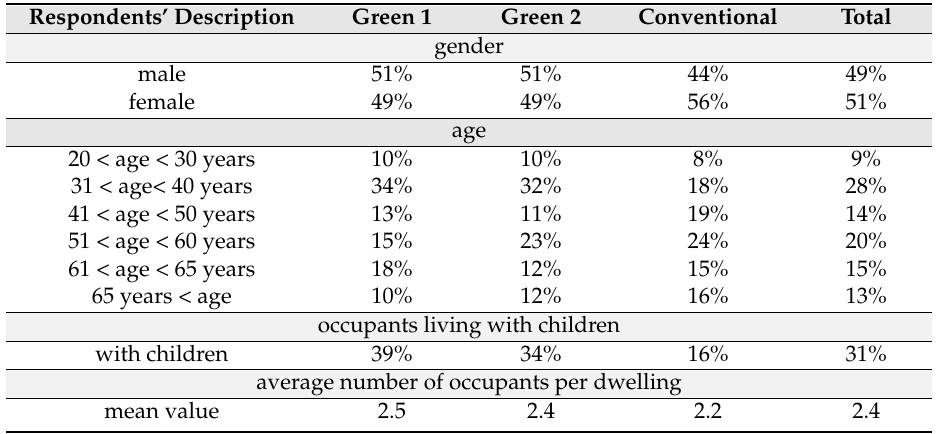
Table 3. Gender distribution, average number of occupants per dwelling and percentage of occupants living with children.